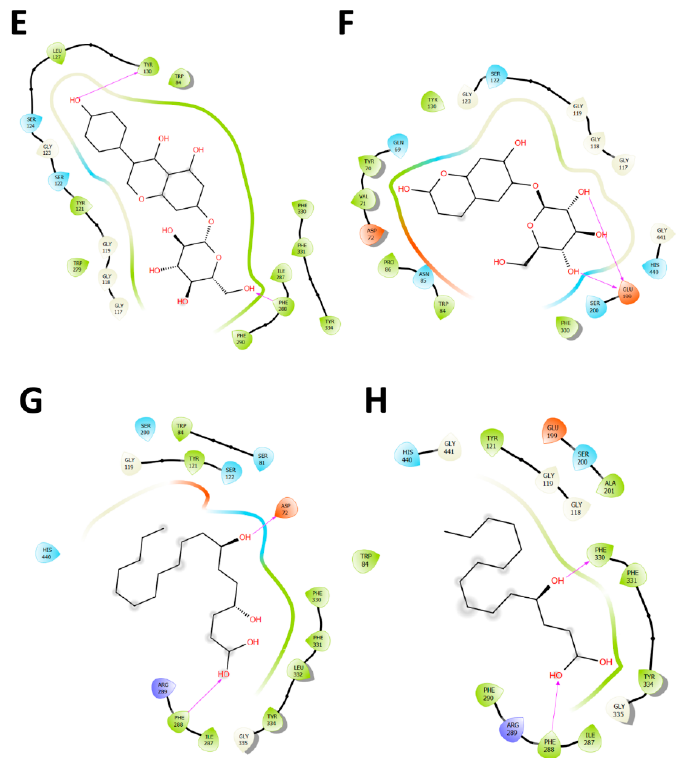
Figure 3. Two-dimensional diagram of Torpedo californica acetylcholinesterase ( Tc AChE) catalytic site and hydrogen bond interactions of each main and most abundant compounds obtained from the pulp and seeds extracts. ( A ) Quercetin-3- O -glucoside-acetate (flavonoid); ( B ) Lupinisoflavone (isoflavone); ( C ) Genistein-7- O -di-glucoside (isoflavone); ( D ) Ononin (formononetin 7- O -glucoside) (isoflavone); ( E ) Genistein-7- O -glucoside (isoflavone); ( F ) Aesculetin-7- O -glucuronide (coumarin); ( G ) Dihydroxy-octadecaenoic acid (fatty acid); ( H ) Hydroxy-pentadecanoic acid (fatty acid).